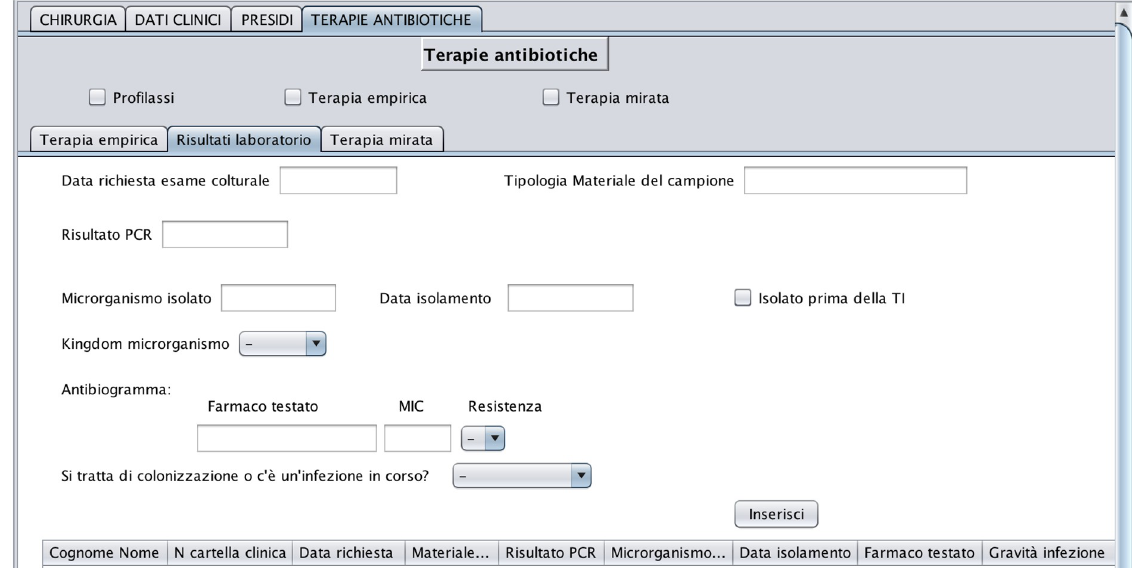
Fig 13. Therapy panel (Terapie antibiotiche) and lab sub-panel (Risultati laboratorio).